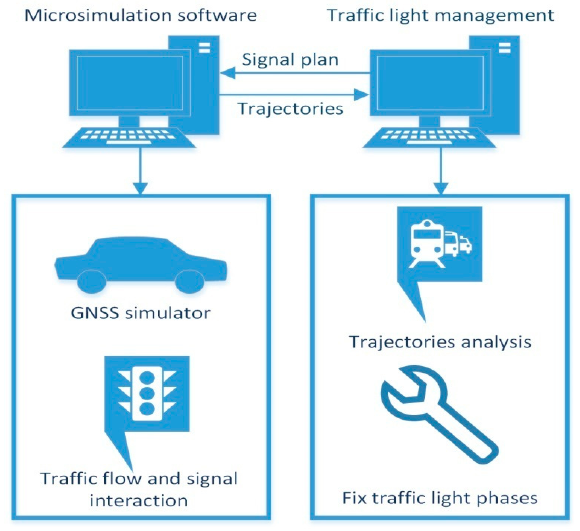
Figure 4. Traffic signal algorithms testing lab.